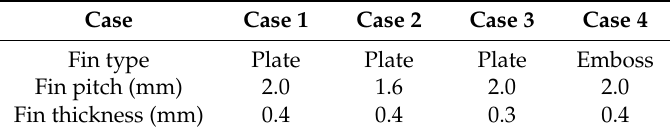
Table 4. Specification of physical model.